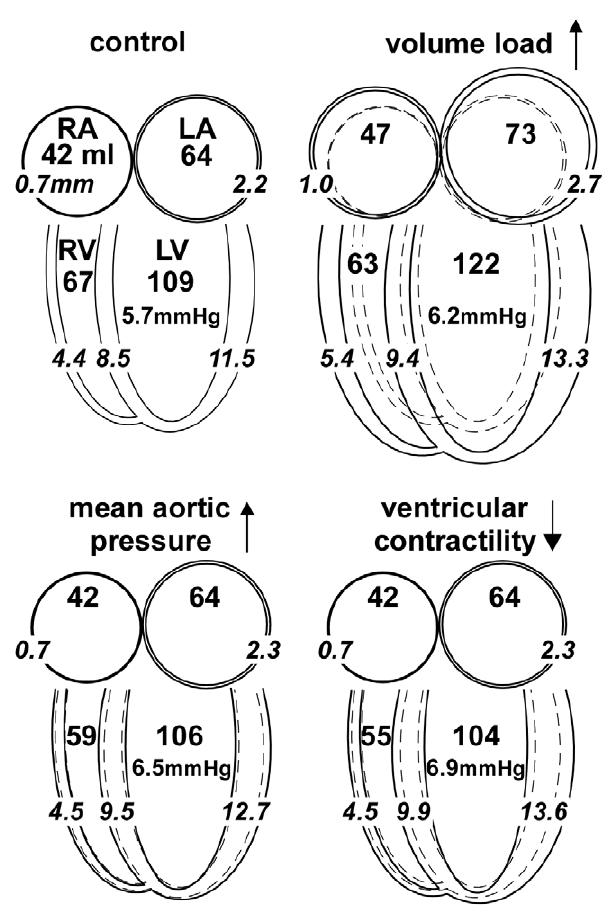
Figure 8. Adaptation to a 20% change of pump load and contractility. Mean volumes of right and left atria (RA, LA) and right and left ventricles (RV, LV), respectively, are indicated by the larger numbers in ml. Mean thicknesses of atrial and ventricular walls are indicated by italic numbers in mm. Drawn changes in geometry are exaggerated for better visibility. End-diastolic pressures are indicated in mmHg. With 20% increase of stroke volume, all volumes and thicknesses increase (eccentric hypertrophy), except for RV volume. With 20% increase of mean aortic pressure, walls thicken, while geometry does not change much. With a 20% decrease of LV and septal contractility, these walls thicken, while further geometry is preserved.